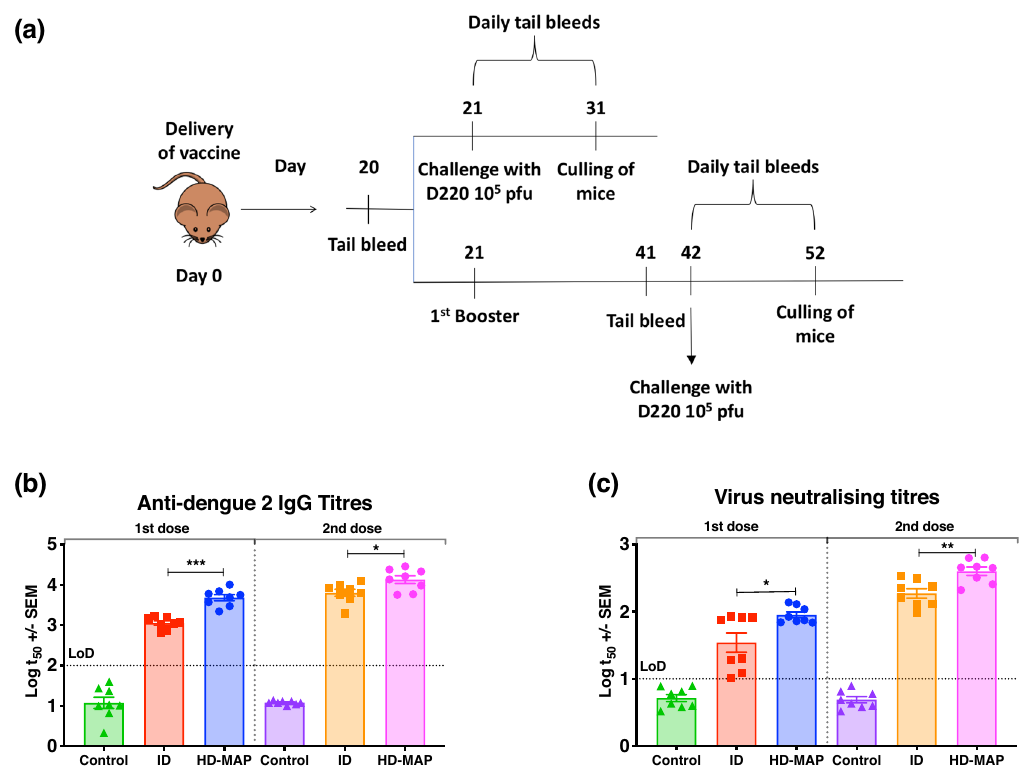
Fig. 5 Evaluation of BinJ/DENV2-prME and DENV2 VLP vaccines in female AG129 mice. a Experimental time-course and vaccination regimen. Female AG129 mice ( n = 8) were vaccinated through ID or HD-MAP with either 1 µg of BinJ/DENV2-prME or saline (control). The fi rst group was challenged with 10 5 pfu D220 after a single dose, whereas the second group was given a booster dose and challenged 21 days later. Tail bleeds were taken 20 days post fi rst immunization for the single dose and day 41 for the two-dose groups. Following virus challenge, daily tail bleeds were taken for 10 days to monitor survival, viremia and NS1 levels. b The IgG response was determined for sera taken 10 days after the fi nal vaccination and mid-point antibody titres (t50) plotted. c Neutralizing antibody titres 10 days post fi nal vaccination expressed as PRNT 50 against DENV2 ET00. Note: each symbol represents a single mouse. Lines indicates mean antibody titres with bars showing ±SEM. **** p ≤ 0.0001, *** p ≤ 0.0003, ** p ≤ 0.002, * p ≤ 0.03 assessed by one-way analysis of variance (ANOVA, α -level